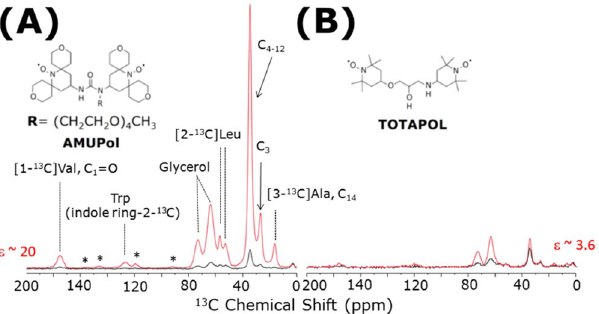
Figure 1. Higher Dynamic Nuclear Polarization (DNP) efficiency of the AMUPol polarizing agent. One- dimensional 13 C CPMAS NMR spectra of selectively 13 C-labeled cytochrome b 5 incorporated in DMPC MLVs with microwave irradiation on (red), and off (black). Cytochrome b 5 was selectively 13 C-labeled with [1- 13 C] valine, [2- 13 C] leucine, [3- 13 C] alanine, and tryptophan (indole ring-2- 13 C), as discussed in the main text. Chemical structures of biradical polarizing agents are shown in ( A ) AMUPol, and ( B ) a conventional polarizing agent, 1-(TEMPO-4-oxy)-3-(TEMPO-4-amino)propan-2-ol (TOTAPOL) as insets. (A) 10 mM AMUPol, or (B) 10 mM TOTAPOL in [D 8 ]glycerol/D 2 O/H 2 O (60/30/10 volume ratio) were used as DNP polarization agents. The signal enhancements ( ε ) of ~20 with 10 mM AMUPol, and ~3.6 with 10 mM TOTAPOL, as described in Table 1. The samples were spun at 8.5 kHz MAS, and sample temperatures were kept at 99.5 K. A CP contact time of 0.8 ms, a 100 kHz SPINAL64 pulse sequence 101 to decouple protons during the signal acquisition time of 25.9 ms, and a recycle delays of 3.9 s (for 10 mM AMUPol, A), and 3.3 s (for 10 mM TOTAPOL, B) were used. Total experimental time was 3 min. Spinning side bands are indicated by asterisks in the spectra. A background signal arising around 0 ppm is from the silicon rubber seal used in MAS rotors.